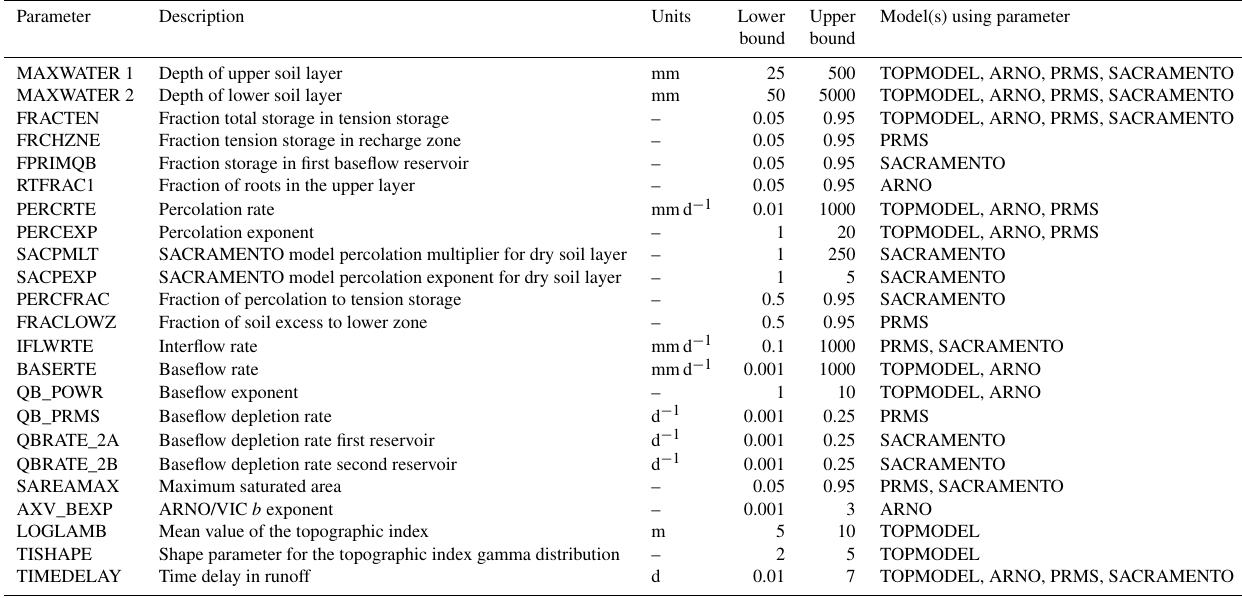
Table 2. FUSE parameters and defined upper and lower bounds.